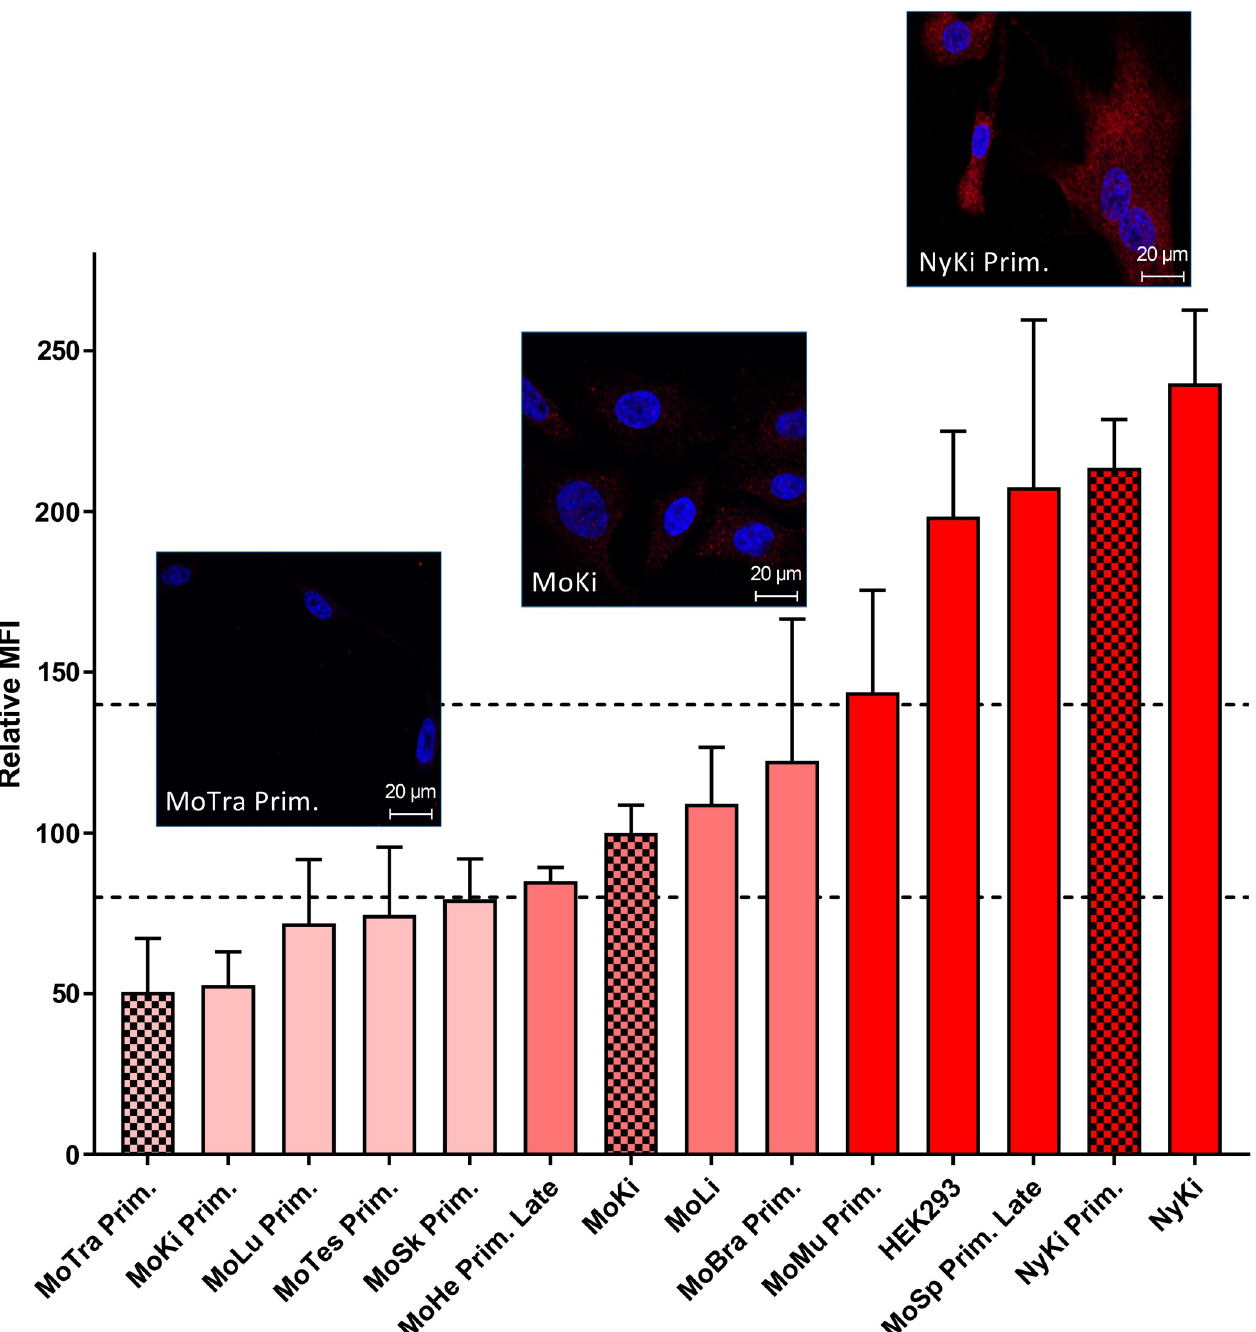
Fig 3. Percentage of NPC1 expression levels in comparison to MoKi cell line determined with flow cytometry. For comparisons of NPC1 expression levels in different cell cultures, the mean fluorescence intensity (MFI) value of the MoKi cell line was set to 100% and the expression levels of the other cells were referred to the MoKi cell line. NPC1 receptor expression levels: Low expression level (light red: below 80%), moderate expression level (medium red: 80– 140%), high expression level (dark red: over 140%). Confocal pictures of three representatives for different NPC1 expression levels: MoTra Prim (low), MoKi (moderate), NyKi Prim